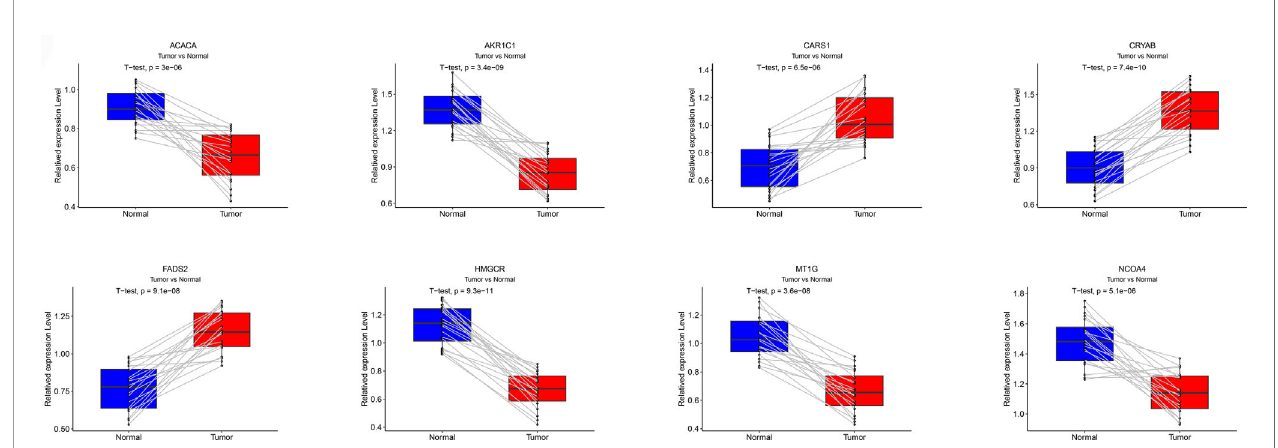
FIGURE 13 | Validation of qRT-PCR. The mRNA expression levels for each FRG in the signature was veri fi ed